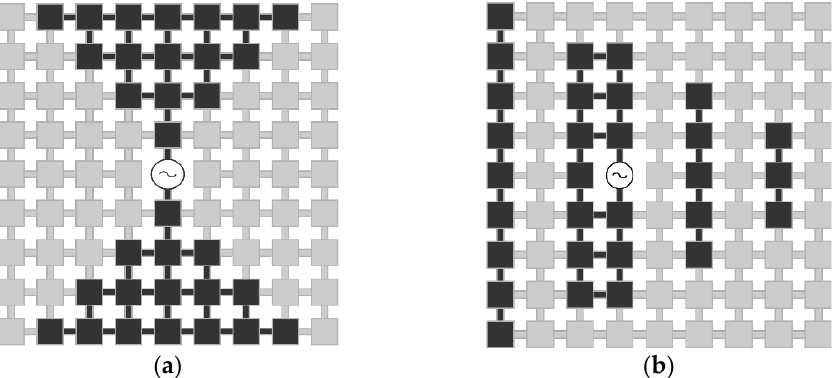
Figure 2. The shape-morphing capability of the pixel antenna is illustrated by representing different configurations (( a ) bowtie pixel antenna ( b ) Yagi pixel antenna).